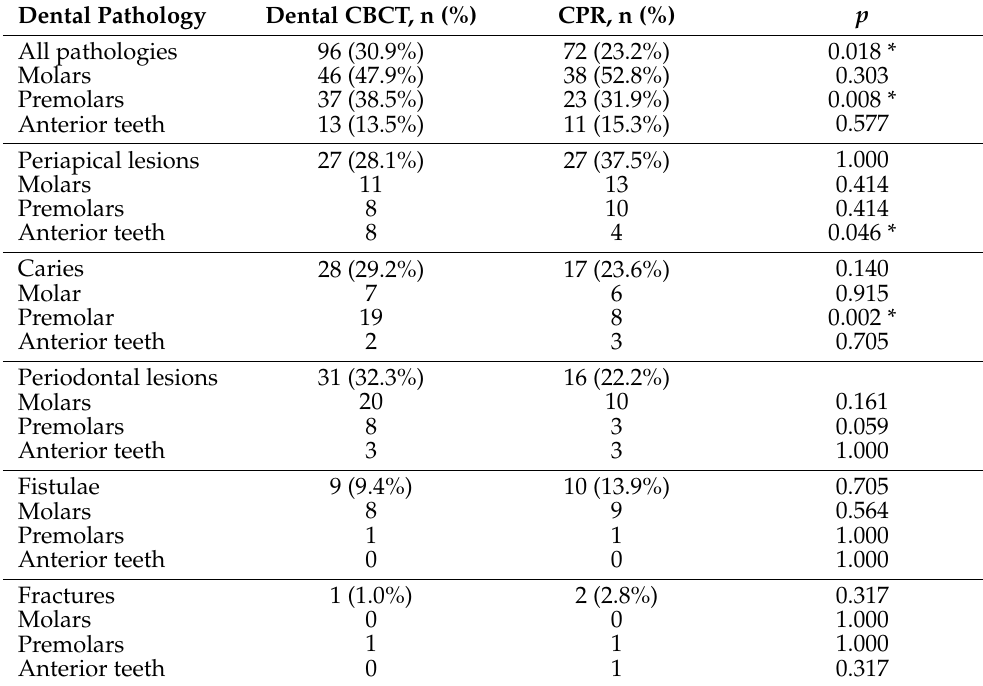
Table 3. Comparison of dental pathologies diagnosed by CBCT and CPR in 331 maxillary